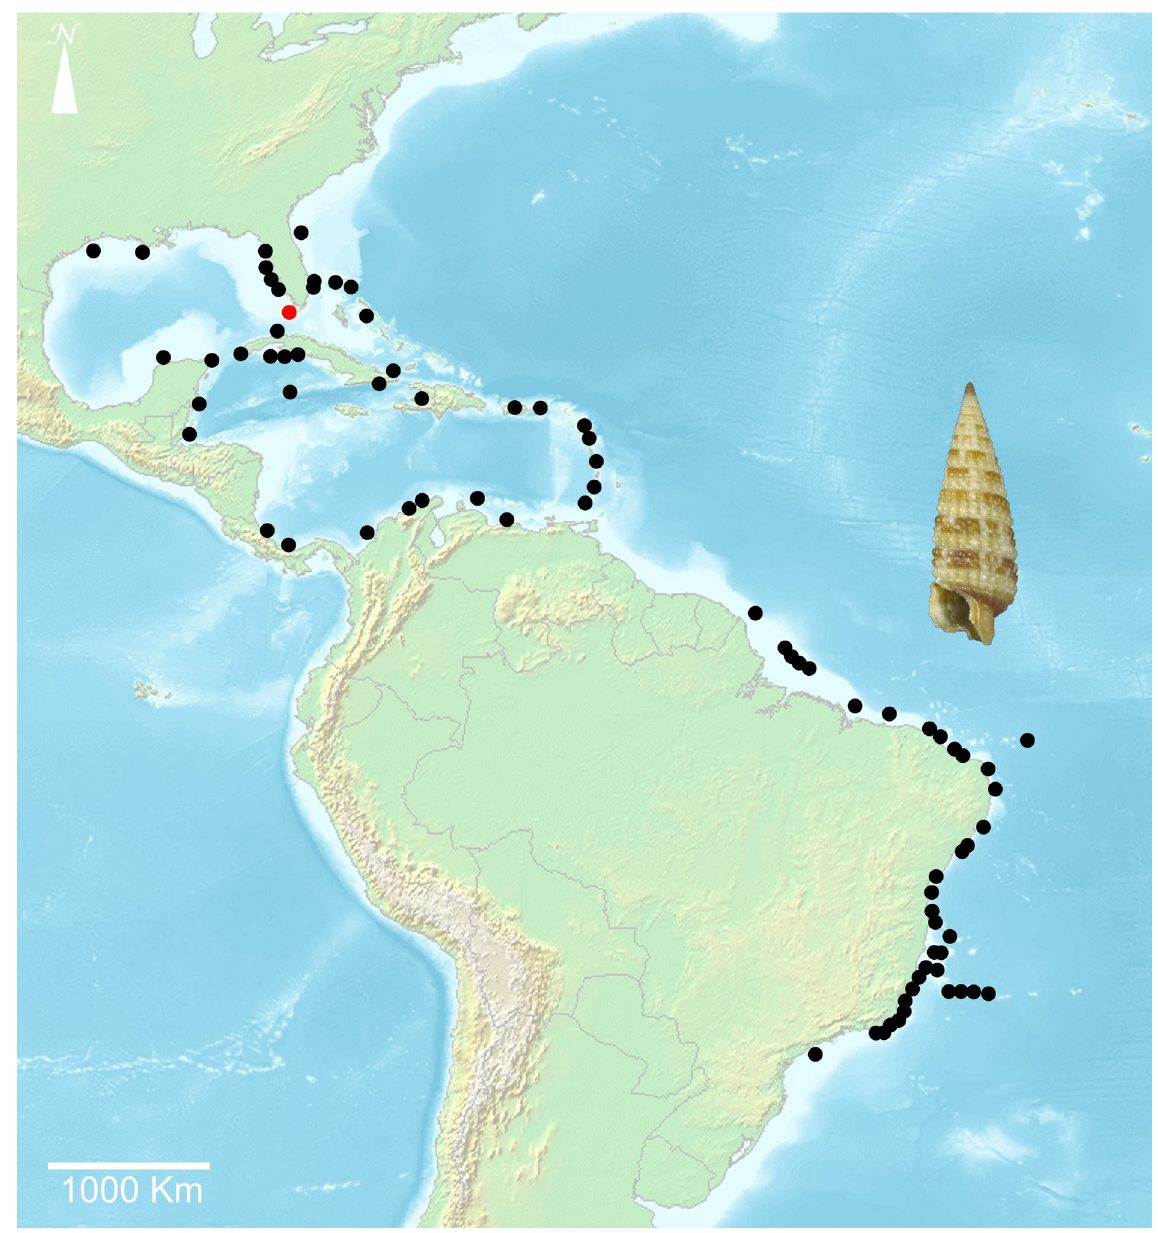
Fig. 56. Distribution map of Monophorus olivaceus (Dall, 1889); red circle = type locality.